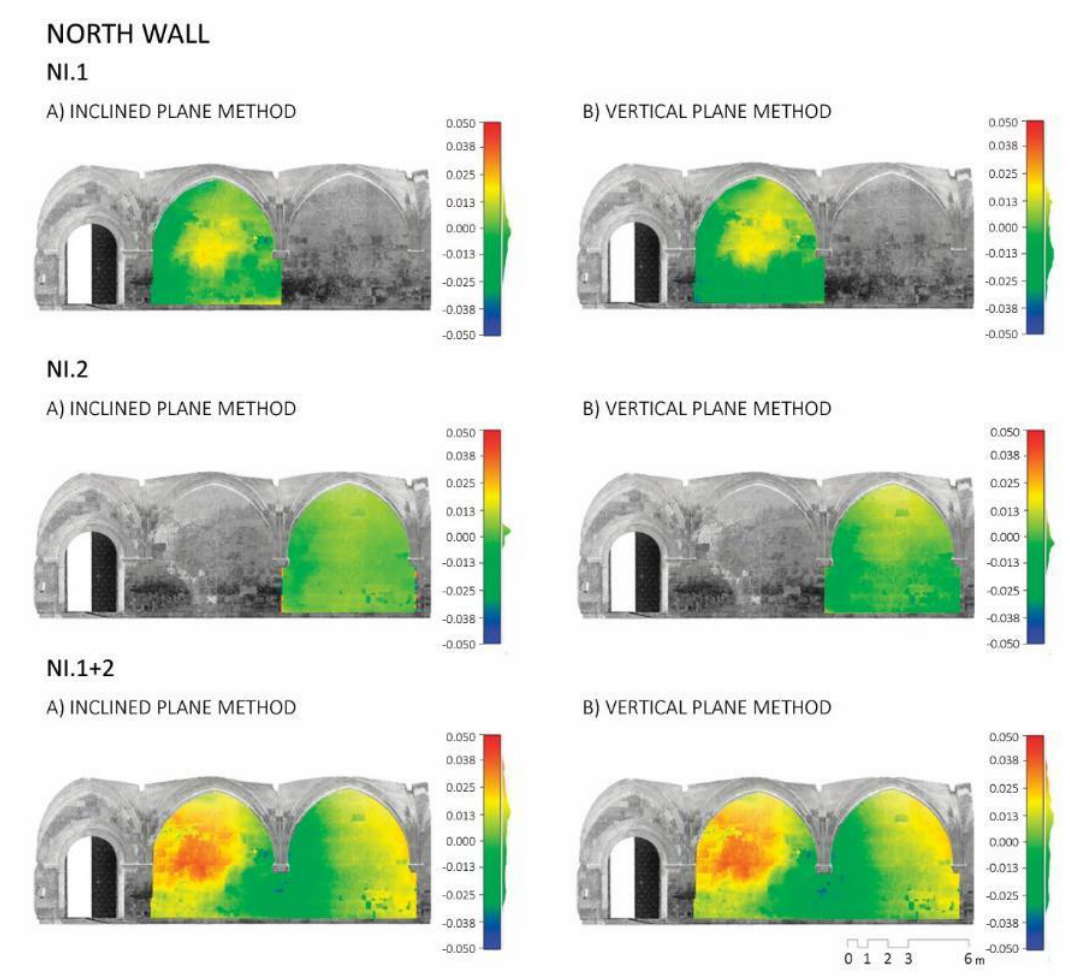
Figure 9. Distance maps of inner north wall (units in meters).